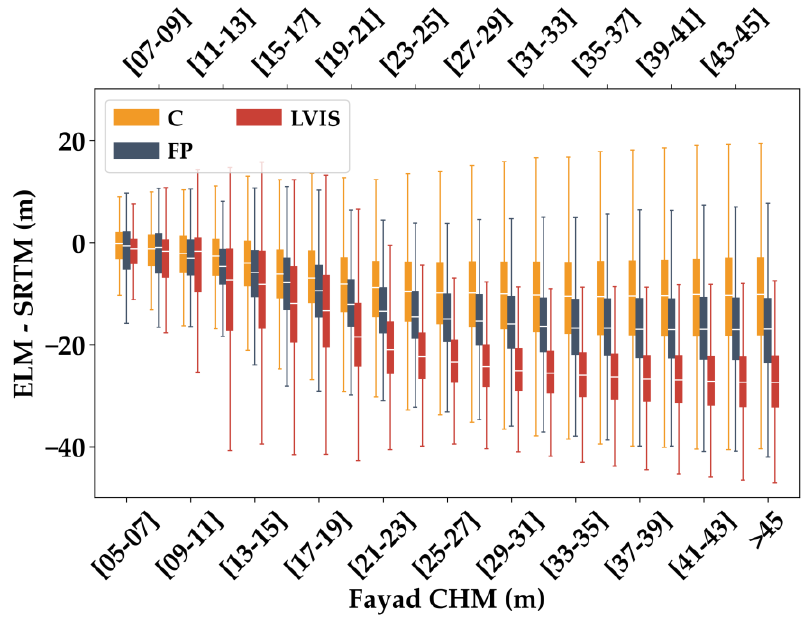
Figure 7. Boxplots of the difference between the elevation of each waveform’s lowest mode (ELM) and SRTM from GEDI’s coverage (C) and full-power (FP) lasers, as well as those from LVIS. Only waveforms with sensitivity ≥ 98% were selected.